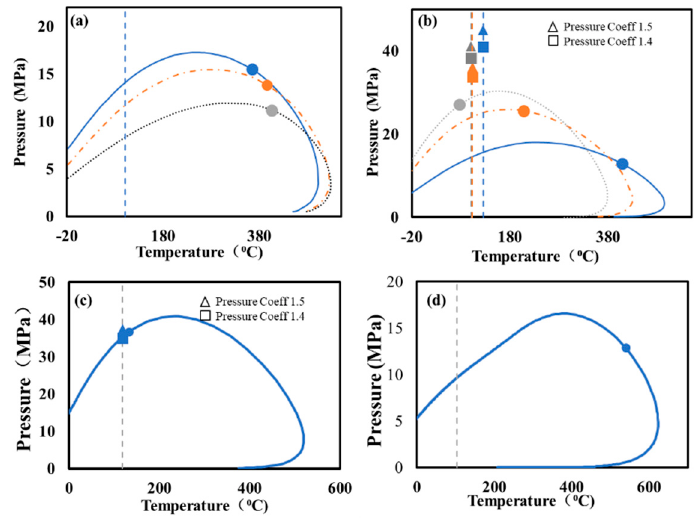
Figure 3. ( a ) Three kinds of phase diagrams of the Eagle Ford shale oil: black oil, volatile oil, and gas condensate [14]; ( b ) three kinds of Bakken oil: all black oil [15]; ( c ) near-critical volatile oil near the center of the Songliao Basin in the G Sag; and ( d ) black oil far away from the center of Songliao Basin. Different lines in ( a , b ) denote different oil samples in the specified shale.